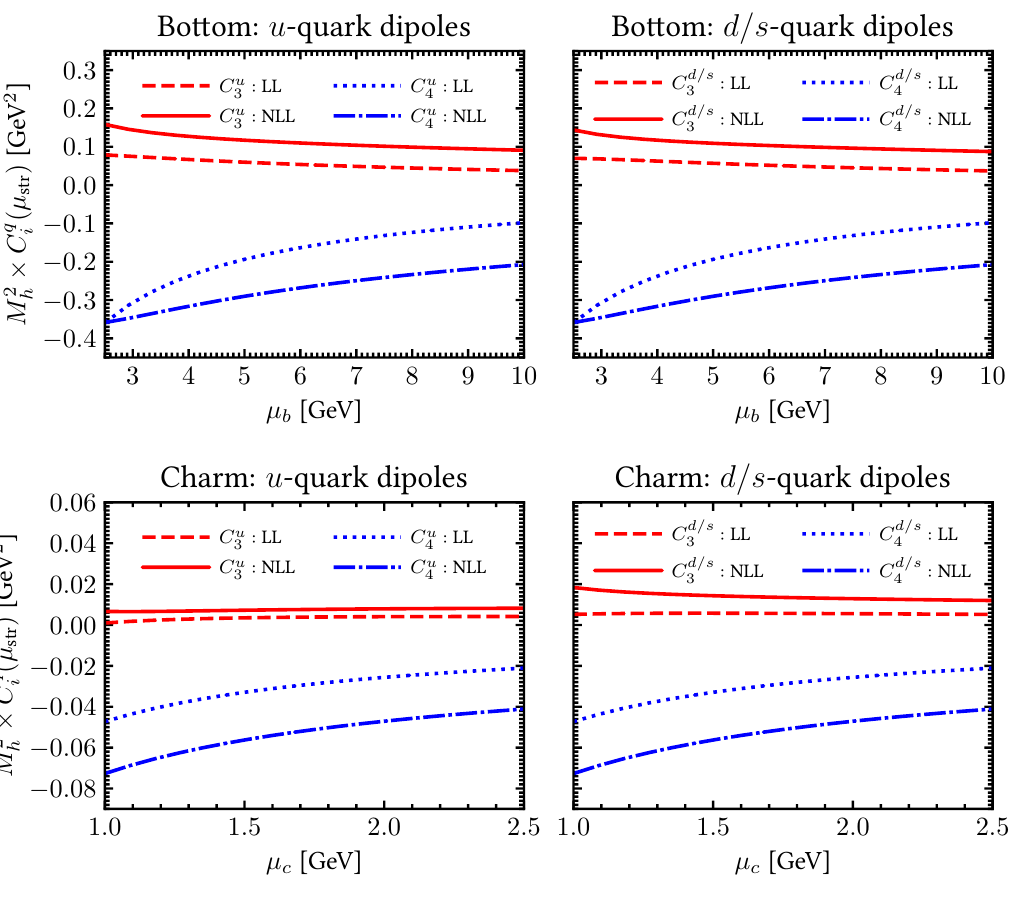
Figure 7 . The same as figure 6, but the dependence on the matching scale at the bottom- and charm-quark thresholds is